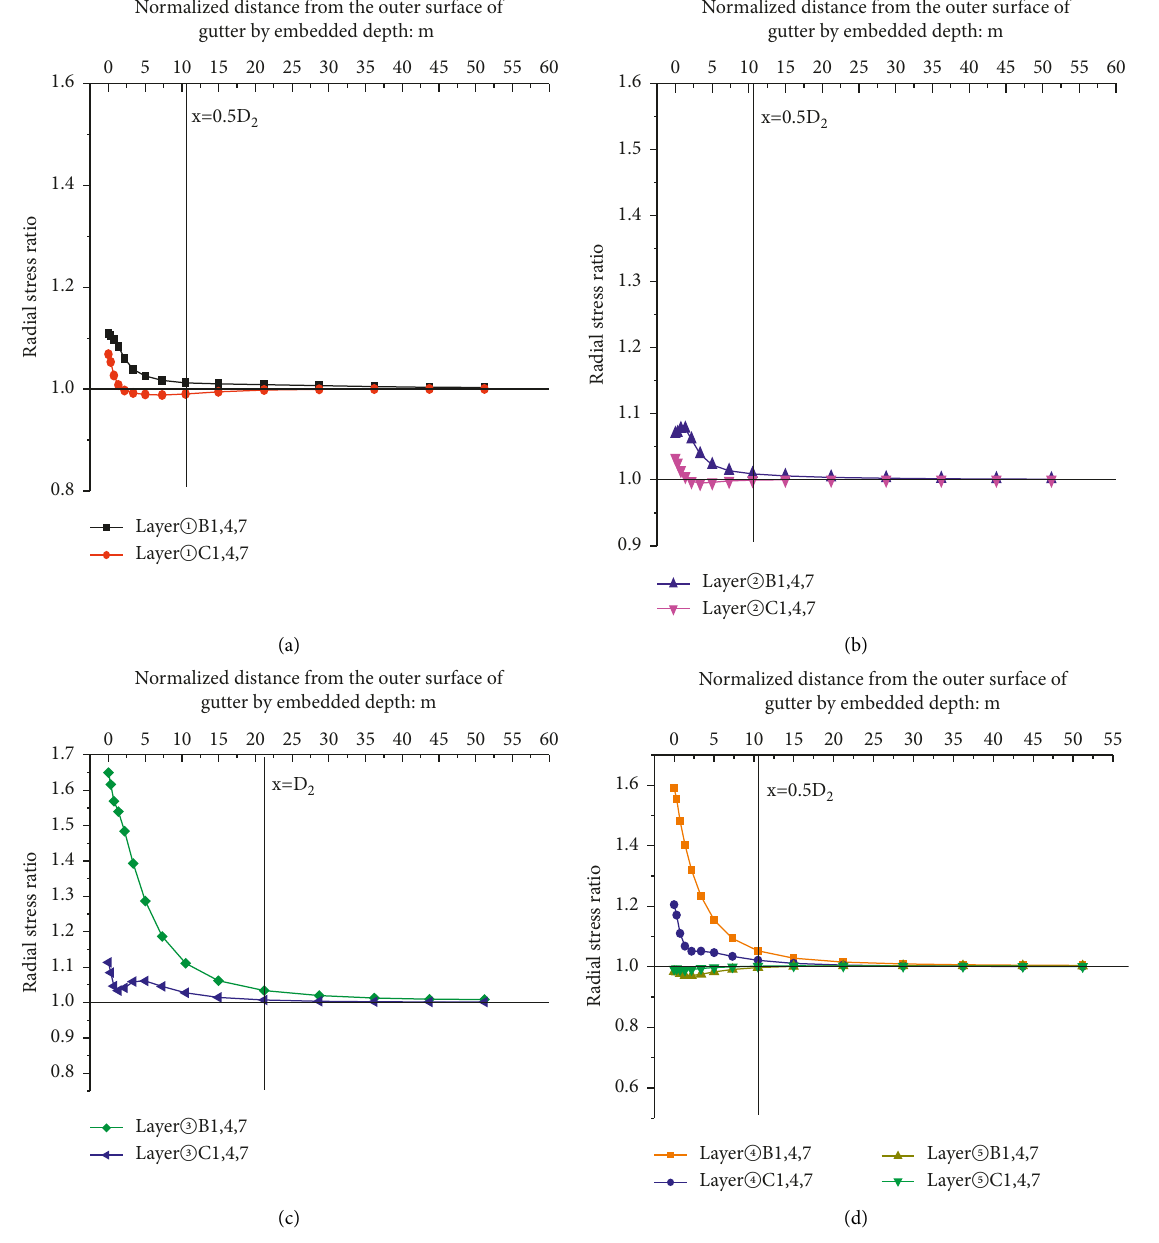
Figure 12: Radial stress at layer ① , ② , ③ , ④ , ⑤ normalized by the radial stress with distance from behind Gutter 7 toward the outside: effect of construction